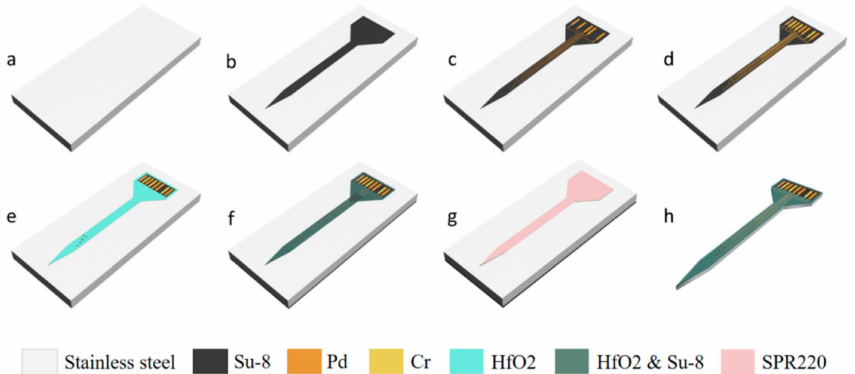
Figure 2. Illustration of the fabrication processes of a multifunctional 3D micro-probe. ( a ) Cleaned stainless-steel (s.s.) substrate. ( b ) Patterns of the probes with SU-8. ( c ) Ti–Pd patterns on